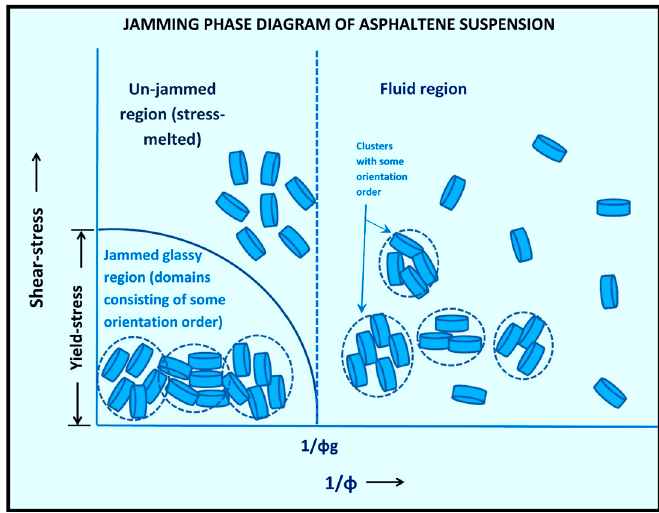
Figure 6. Non-equilibrium jamming phase diagram of suspension.